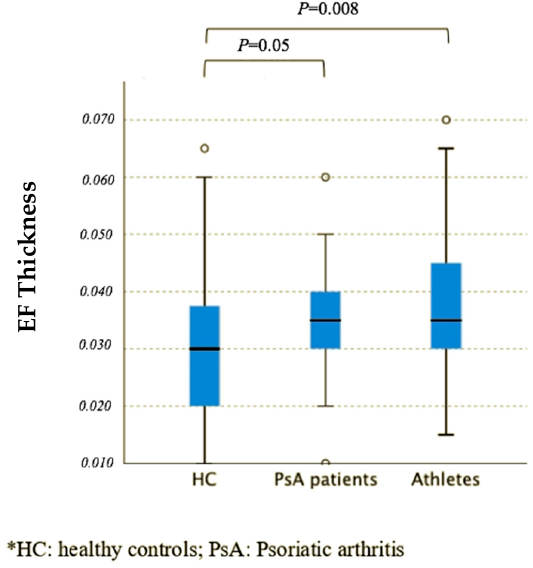
Figure 2. Comparison of the median EF thickness (pooled data of right and left side) between the three groups (independent samples Kruskal–Wallis test). Table 3. Correlation between EF thickness and clinical characteristics in our group of Table 2. Intra and inter-reader reliability; intraclass correlation coe ffi cient (95% con fi dence interval).